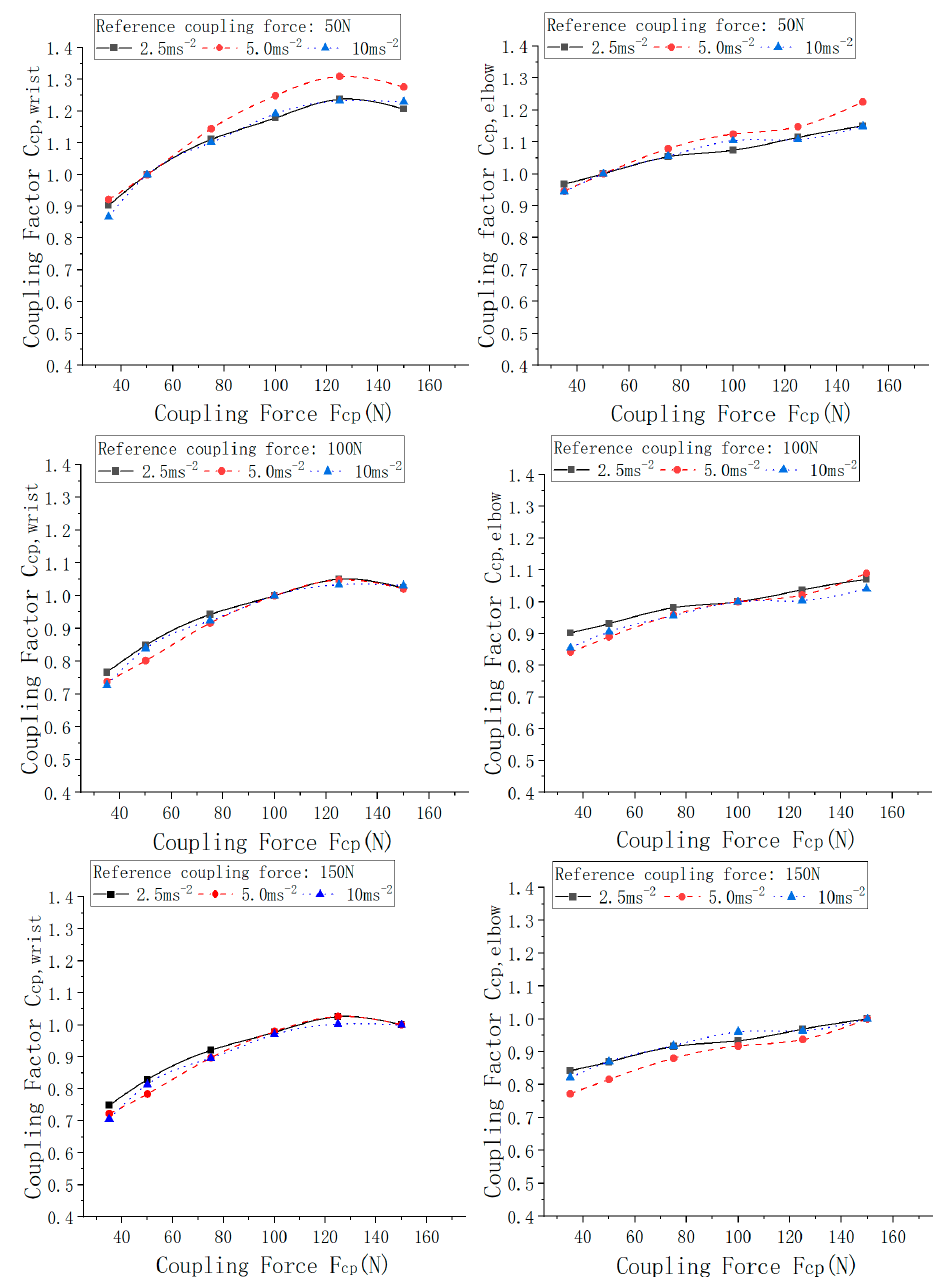
Figure 5. Mean coupling factor measured at the wrist and elbow under various vibration excitation levels for reference coupling forces set at 50, 100 and 150